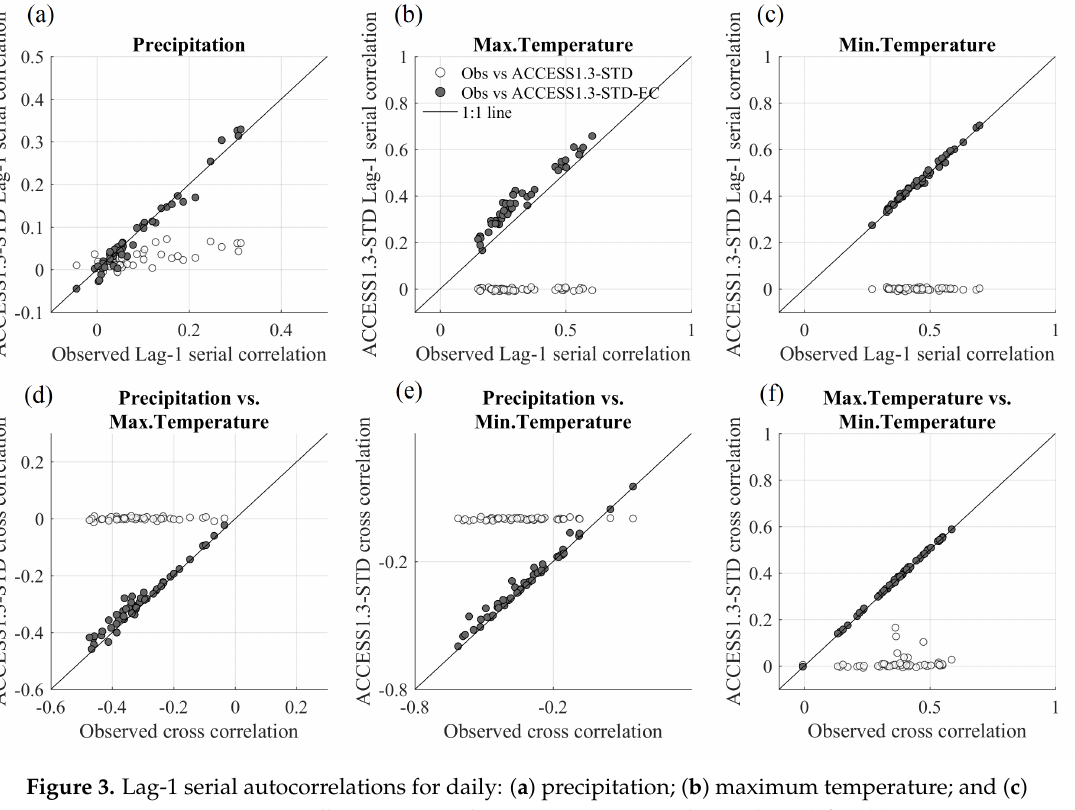
Figure 3. Lag-1 serial autocorrelations for daily: ( a ) precipitation; ( b ) maximum temperature; and ( c ) minimum temperature, as well as cross correlations (Spearman rank correlation) for: ( d ) precipitation vs. maximum temperature; ( e ) precipitation vs. minimum temperature; and ( f ) maximum temperature vs. minimum temperature, for all stations and months for observations and spatially-temporally downscaled ACCESS1.3 data under RCP8.5 scenario over the period of 2071–2100. Median values across the 100 different simulations are shown against the observed